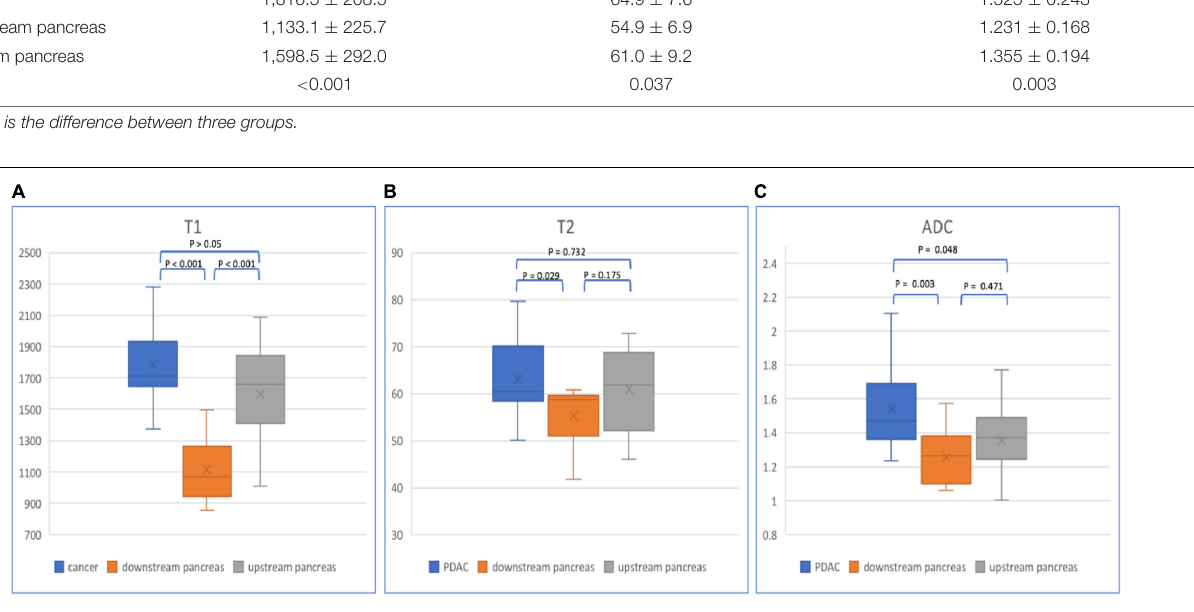
FIGURE 6 | Box plots show T1 (A) , T2 (B) , and ADC (C) values of PDAC, downstream and upstream pancreas. p -values are listed on the upper box according to one-way